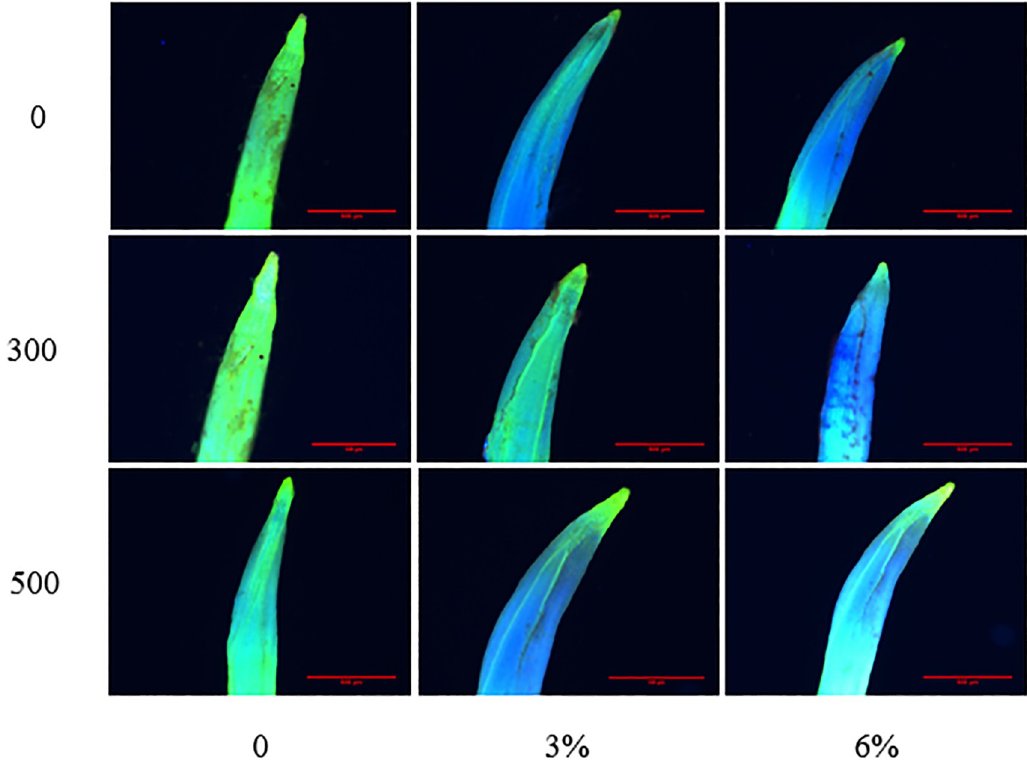
Fig 4. ROS staining of soybean radicle tips on different treatments. The horizontal axis is PEG concentration, the vertical axis is melatonin concentration, and the scale length is 500 μ m.